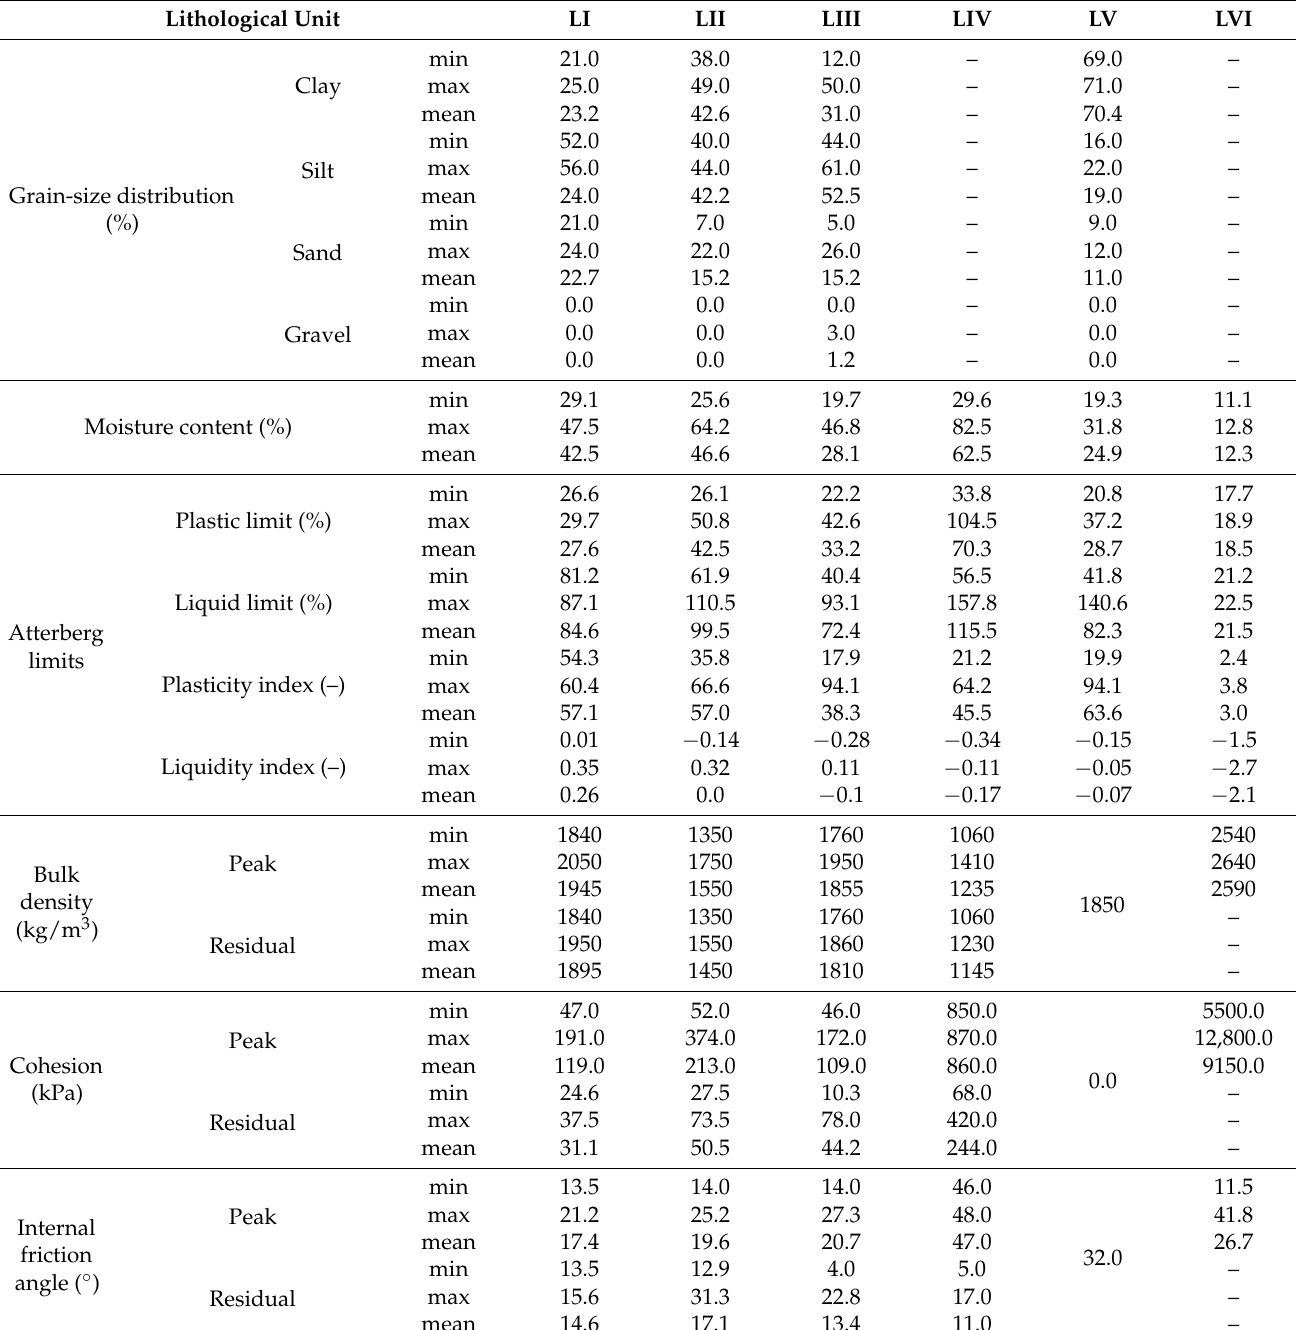
Table 1. Physical parameters of lithological units in the 18S